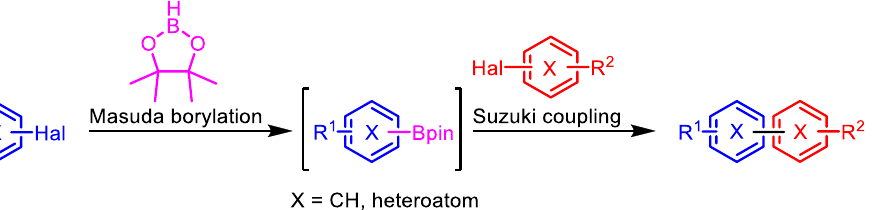
Figure 3. Linkage of Masuda borylation and Suzuki coupling into a one-pot MBSC sequence.